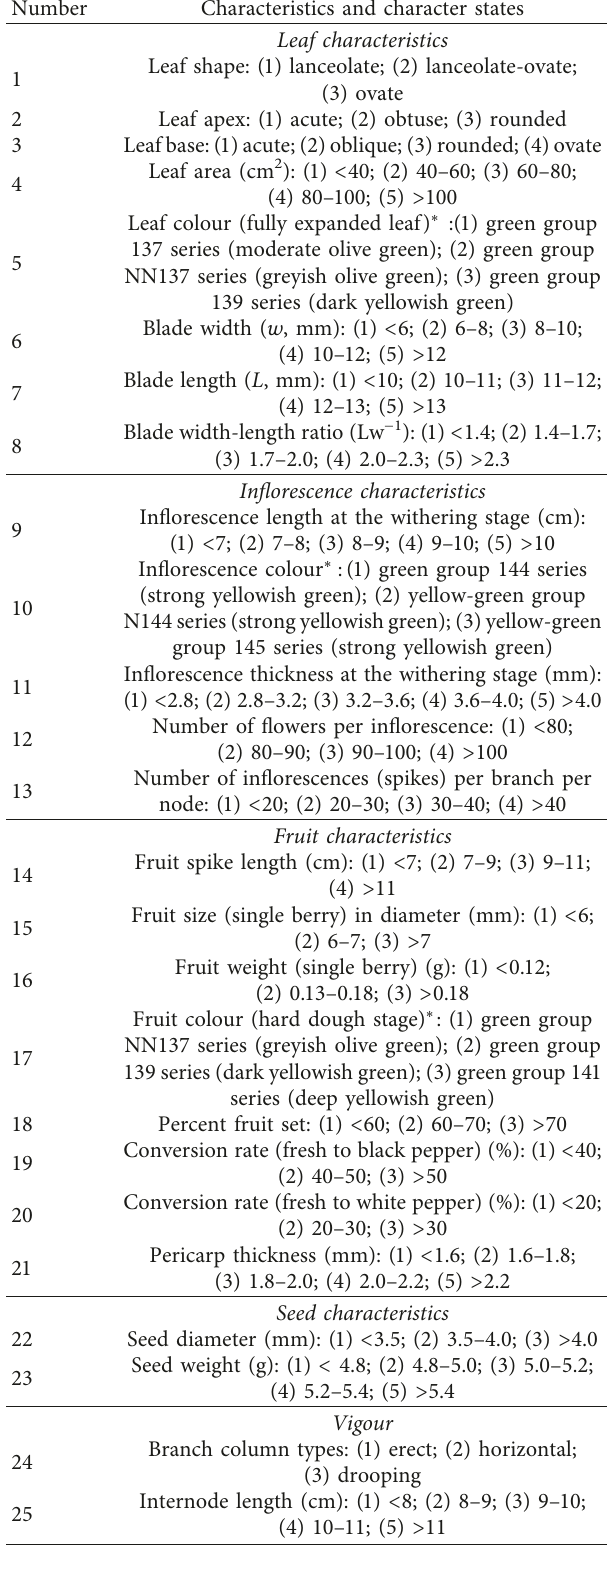
Table 2: Characteristics and character states used for phenetic analysis. Number Characteristics and character states Leaf characteristics